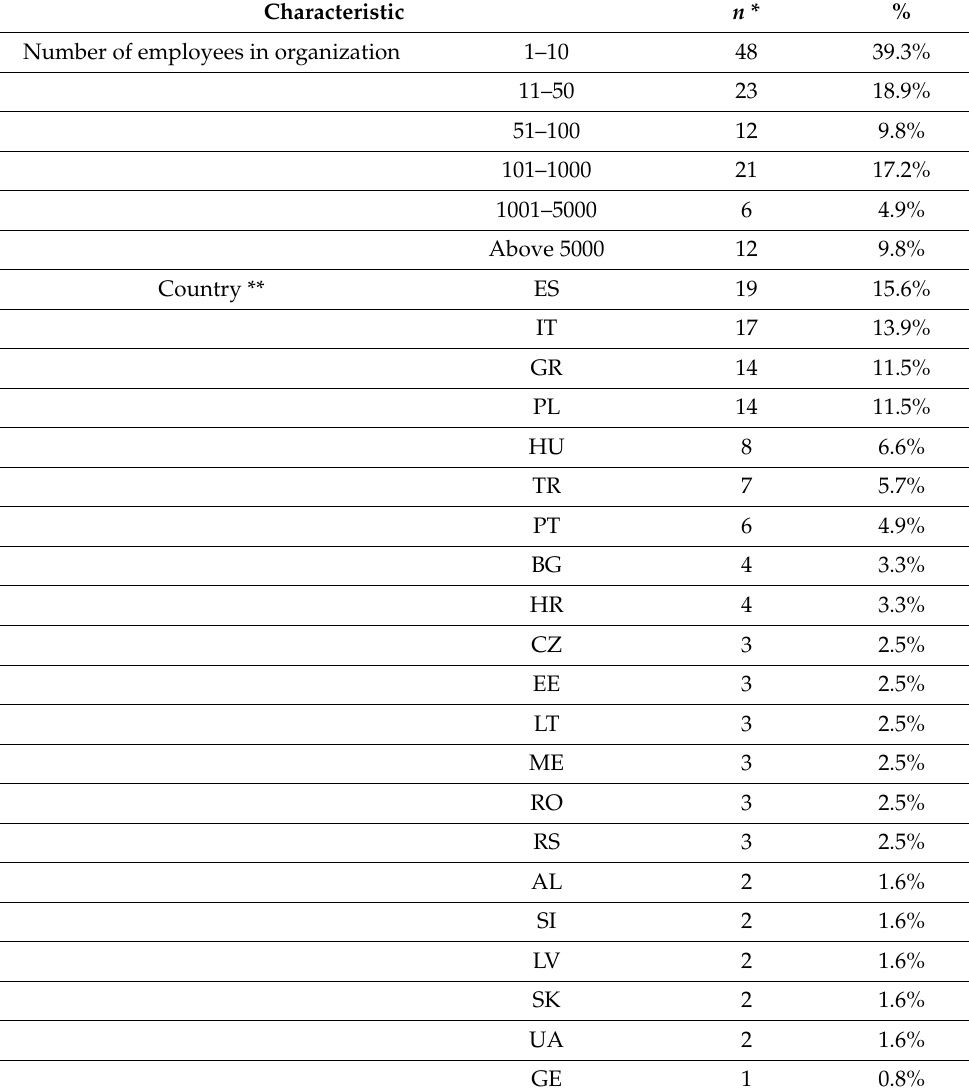
Table 4. Sample characteristics ( n =